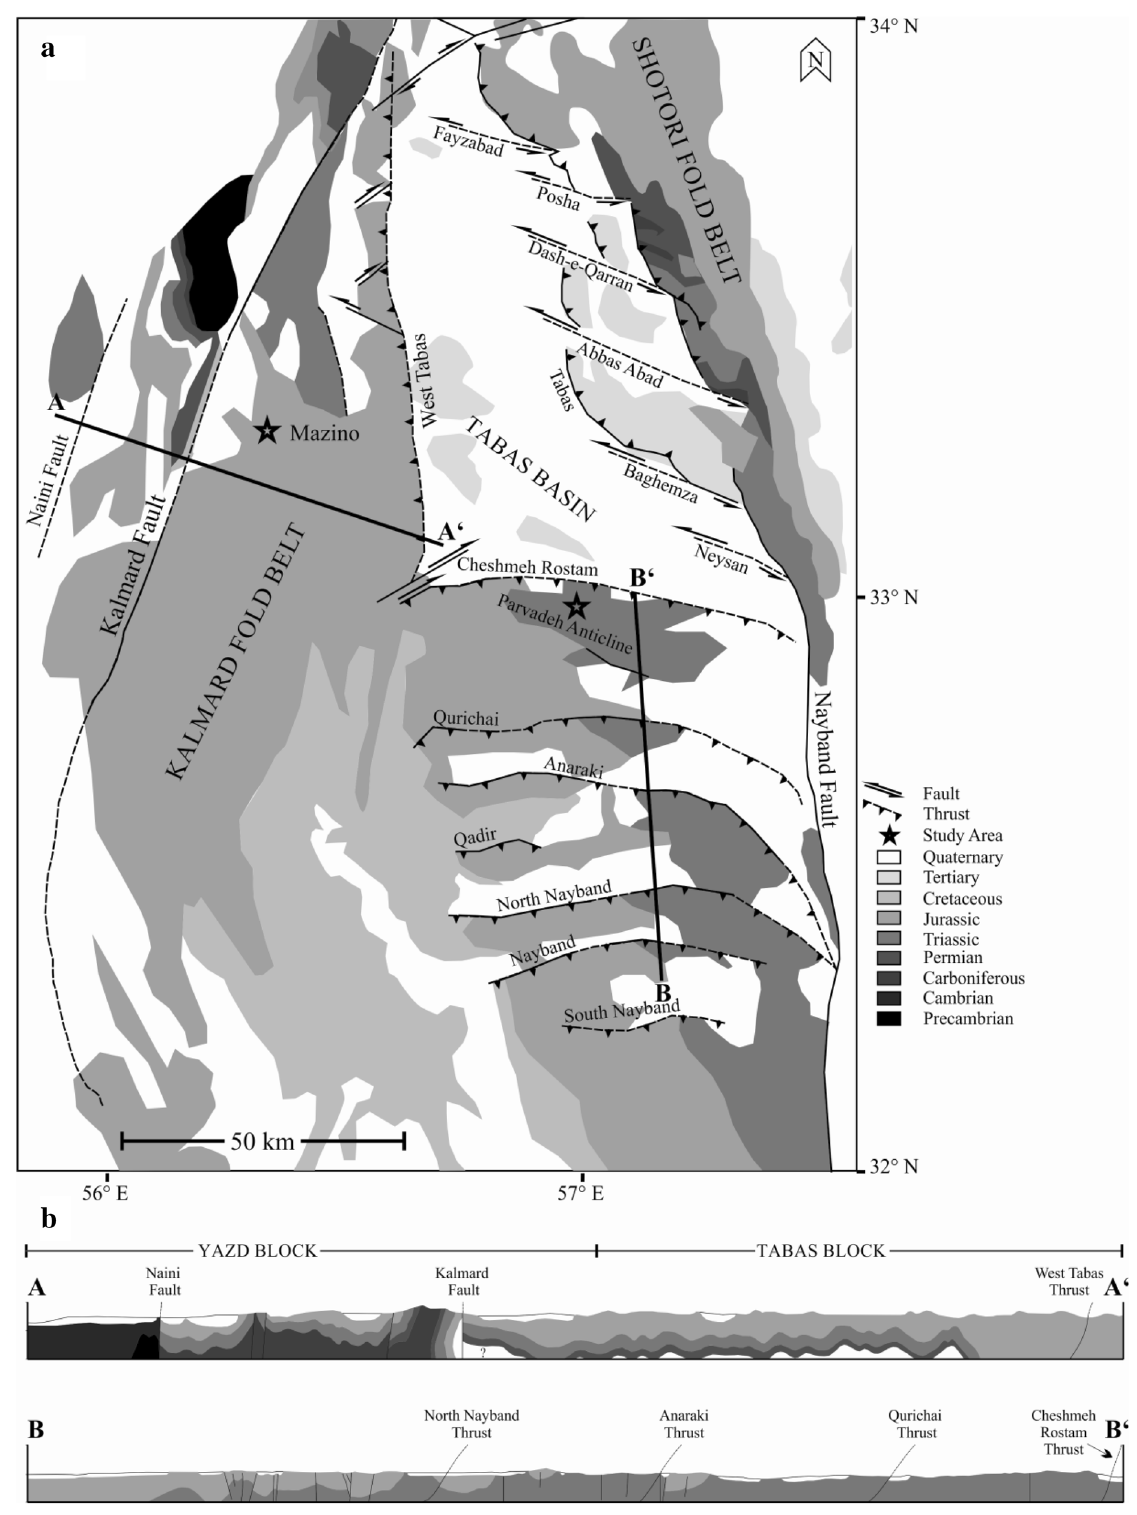
Fig. 1 a Geological map of Tabas block with sampling locations marked, b Geological cross sections along lines AA 0 and BB 0 . Modified after Konon et al.